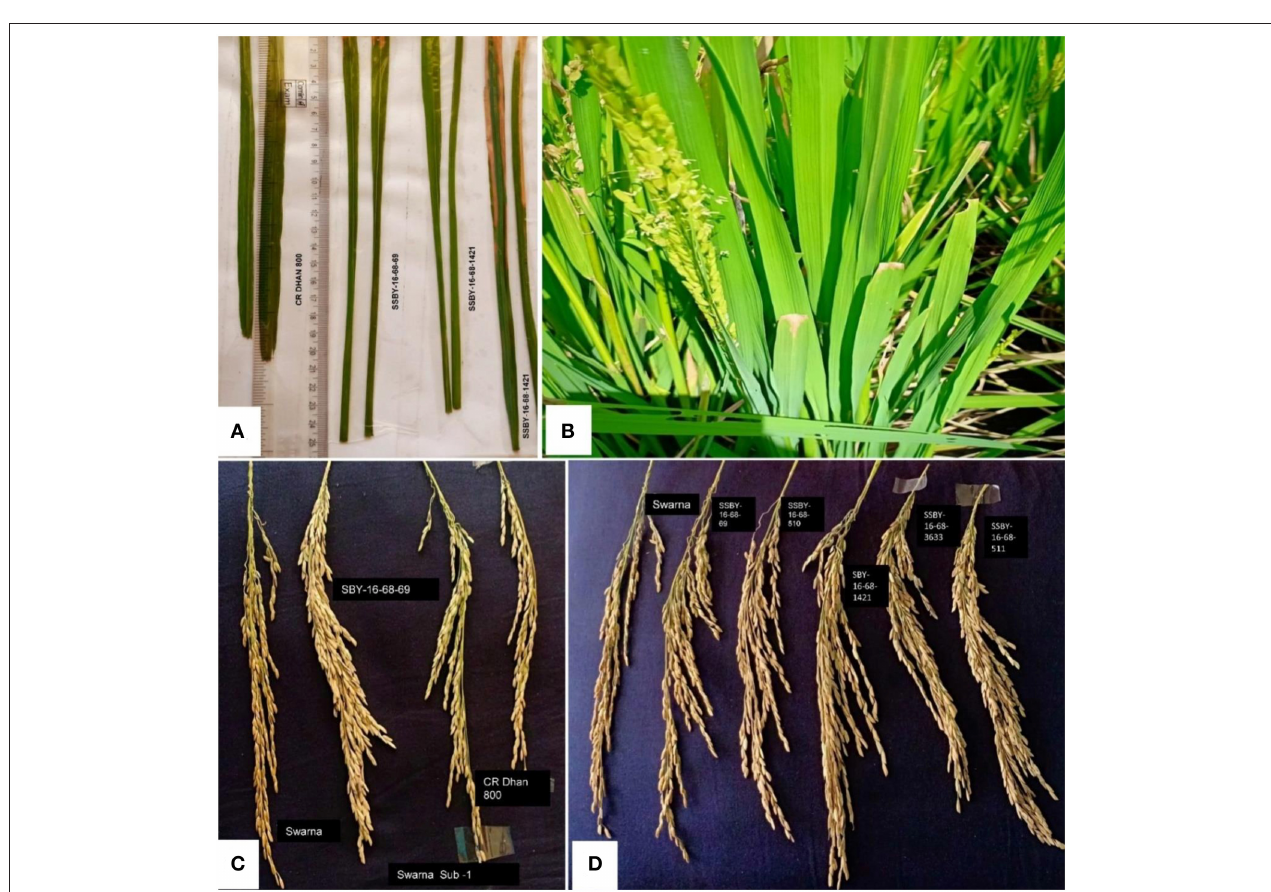
FIGURE 6 | (A) Comparative lesion length of donor parent and pyramided lines; (B) bacterial blight disease inoculated pyramided plant; and (C,D) panicles of donor parents and pyramided lines.